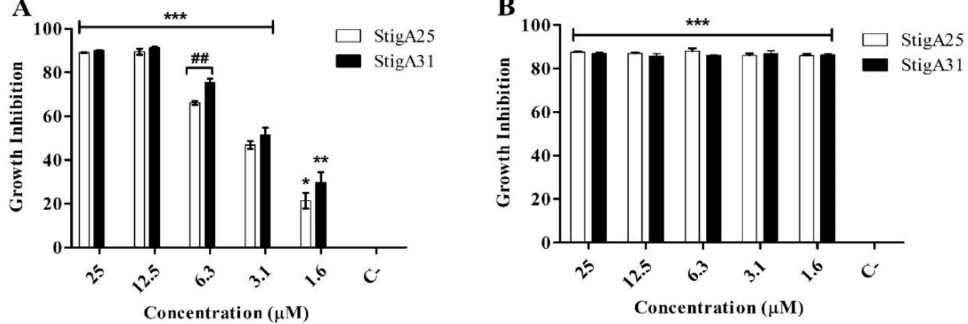
Figure 9. Antiparasitic activity of StigA25 and StigA31 on epimastigote forms of T. cruzi after 12 h ( A ) and 24 h ( B ) of incubation. Negative control is represented by C-. Values represent mean ± SD ( N = 3). *** p ≤ 0.0001, ** p ≤ 0.001 and * p ≤ 0.01 compared to the positive control. ## p ≤ 0.001 compared between the analogs StigA25 and StigA31 at the same concentration. Statistical analysis was performed using ANOVA followed by Tukey’s